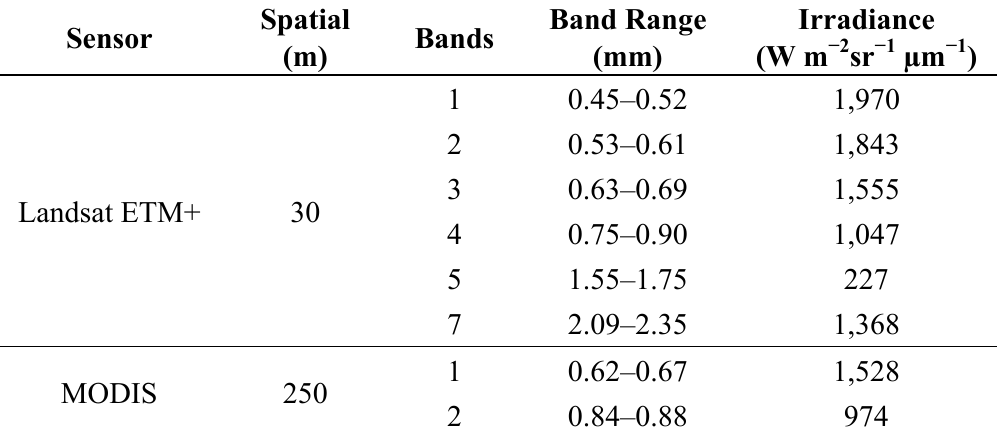
Table 1. Characteristics of satellite sensor data used in the